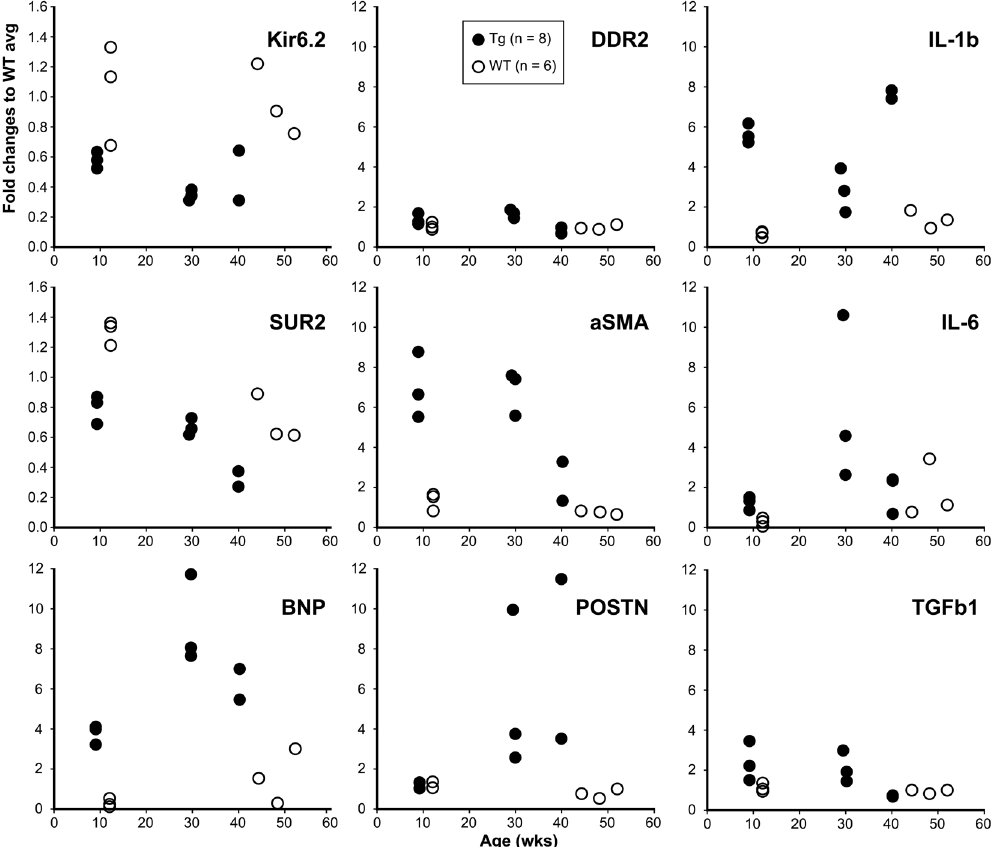
Figure 4. Gene expression analyses in the apex tissue by semi-quantitative real-time PCR. cDNA was synthesized from the total RNA purified from the apex of the left ventricle. Kir6.1TG mice (line 673) were sub- grouped according to the age of weeks (9, 30, 40, respectively), and compared with WT (average 48.2 weeks and 12 weeks). qPCR values were first normalized to RPL4, then calculated fold changes to the average of WT. Each circle indicates the value of each mouse (WT: n = 6, Kir6.1TG 9 weeks: n = 3, 30 weeks: n = 3, 40 weeks: n = 2). Kir6.1r: rat Kir6.1 (transgene), Kir6.2: mouse Kir6.2, SUR2: sulfonylurea receptor type 2, BNP: